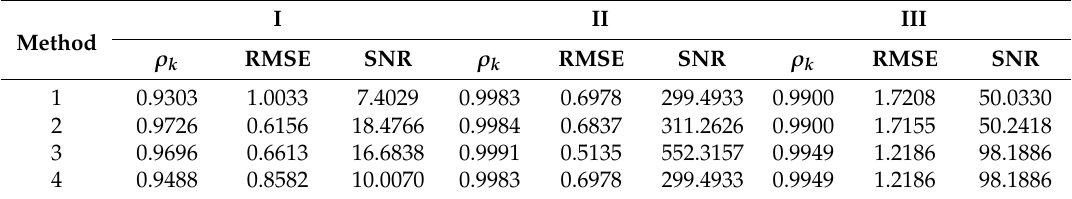
Table 1. The analysis results of the 4 kinds of noise reduction methods after the noise reduction of different data. The indexes are the correlation coefficient, the root mean square error, and the signal-to-noise ratio.